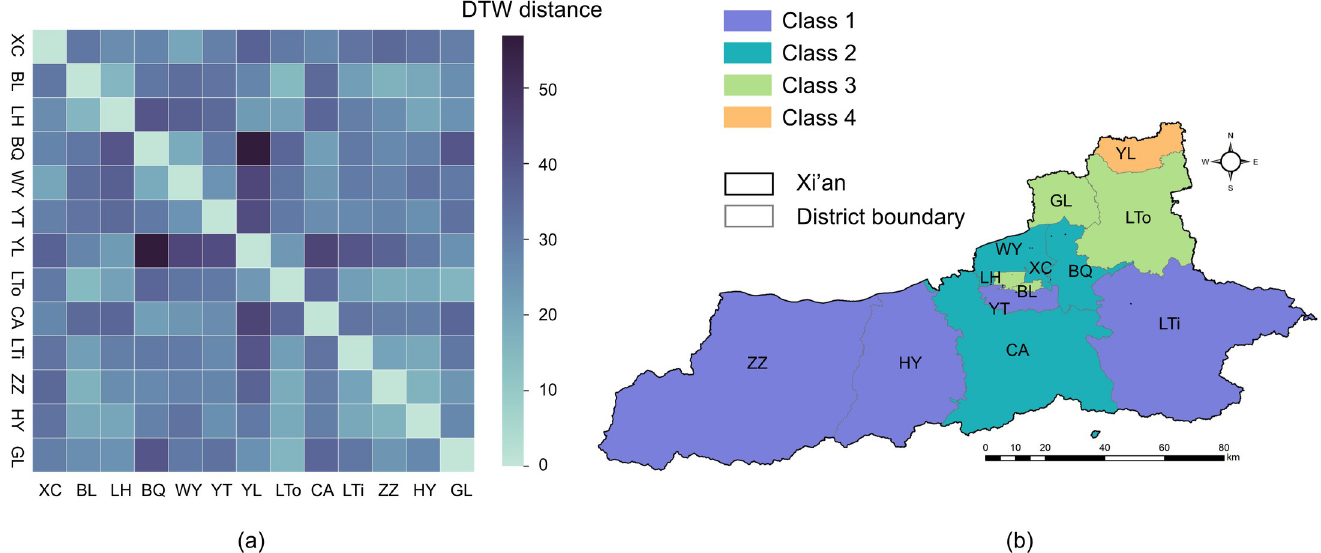
Fig 7. Similarity measurement of urbanization associations with HFRS and cluster analysis. (a) DTW distances between different counties and districts. (b) Four clusters of 13 counties and districts based on DTW distances. The figure was produced in ArcGIS 10.8 (ESRI, Redlands, CA, USA) using shape files representing Xi’an City which were obtained from the basic geographic database in National Catalogue Service For Geographic Information of China (https://www.webmap.cn/ mapDataAction.do?method=forw&resType=5&storeId=2).